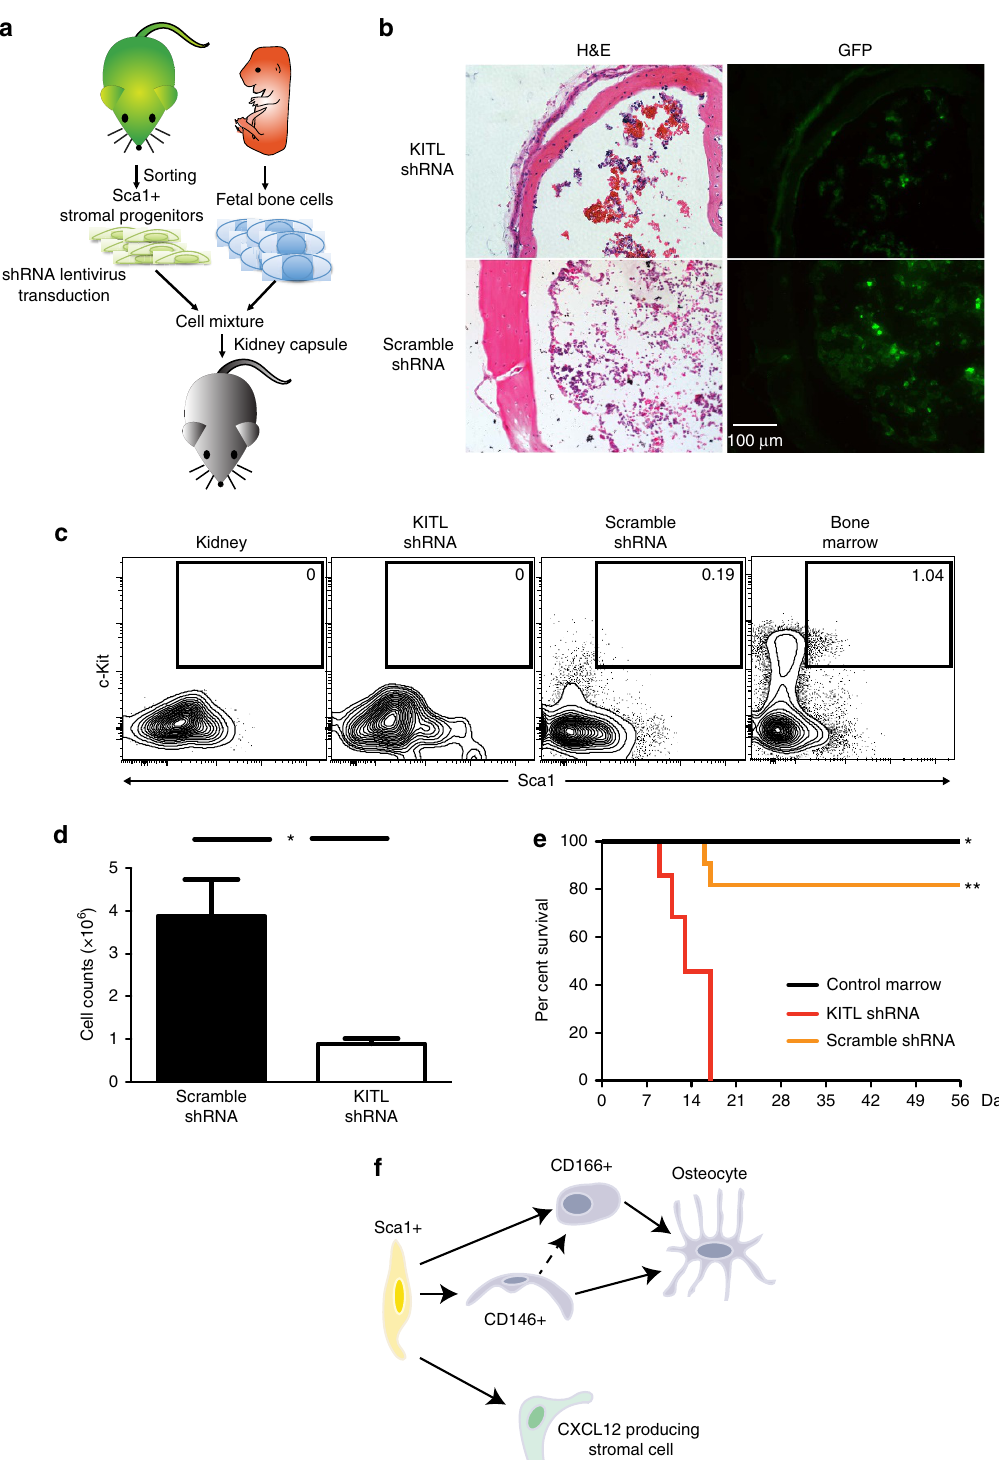
Figure 7 | Disruption of KITL production in Sca1 þ progenitors suppressed hematopoiesis in the ectopic niche. ( a ) Sca1 þ progenitors were transduced with lentivirus as indicated and 1,000 sorted GFP þ Sca1 þ progenitors were co-transplanted with unmarked fetal skeletal progenitors under the kidney capsule. ( b ) Representative cross sections of the engrafted ectopic bone stained with H&E (right) or GFP (left) to identify the donor origin, harvested 1 month after transplant. ( c ) Representative FACS profiles of LSK frequencies that were pre-gated for live, CD45 þ lineage (cid:2) cells. ( d ) Cellularity of the ectopic niche marrow (* P o 0.05, n ¼ 5, student’s t -test). ( e ) Rescue of lethally irradiated mice with 2 (cid:3) 10 5 marrow cells from engrafted ectopic niche generated with either mixed Sca1 þ /shKITL progenitors (red) or with Sca1 þ /Scrambled shRNA progenitors (yellow) or control bone marrow from host tibia (black) ( n ¼ 8). ( f ) The schematic summaries our findings such that Sca1 þ cells are the most primative giving rise to CXCL12 producing stromal cells, CD146 þ cells and CD166 þ cells. CD146 þ and CD166 þ cells are osteo-progenitors. It is possible that CD146 þ is an intermidiary cell fate between Sca1 þ cells and CD166 þ cells. NATURE COMMUNICATIONS|7:13095|DOI: